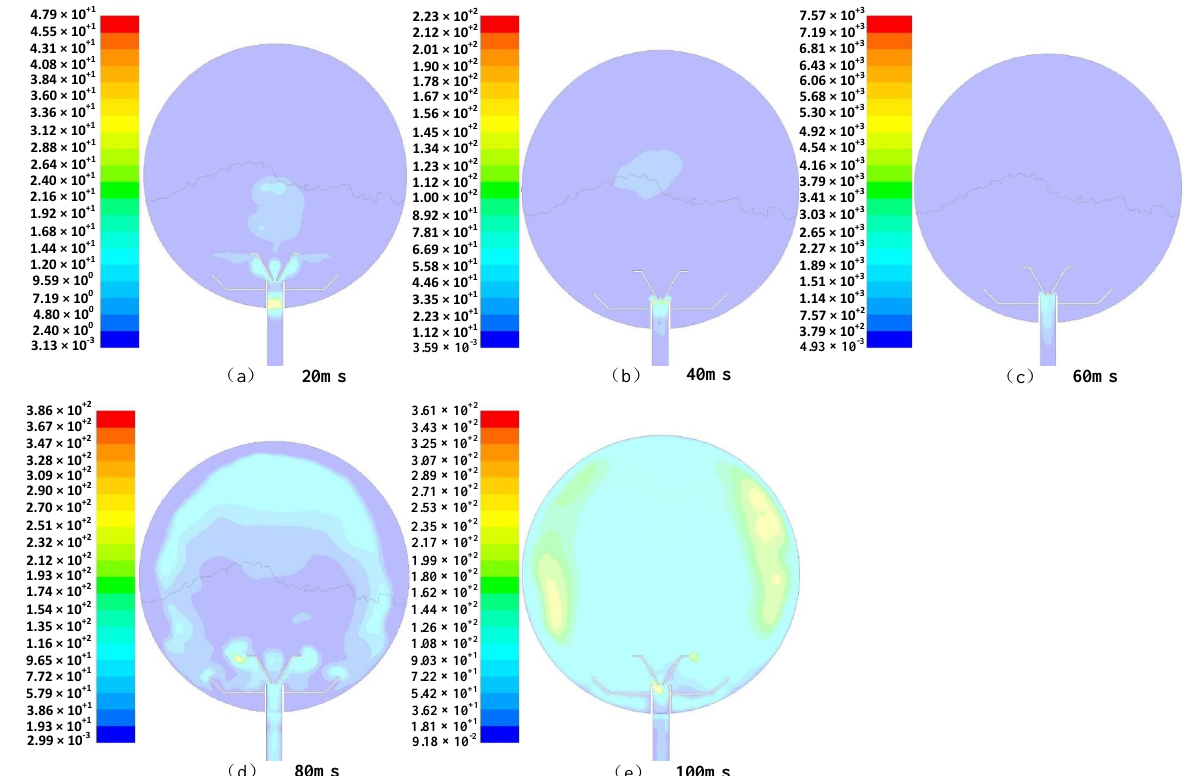
Figure 12. Evolution of turbulent kinetic energy (m 2 /s 2 ). As shown in Figure 13, at the initial moment of dust dispersion, the velocity of the flow field gradually increased and then decreased. When the dust was ignited, the tem- perature increased sharply, and the velocity of the flow field increased sharply until reach- ing its maximum value. Burning dust consumes the kinetic energy of the dust as a result of gravity and mutual friction. Therefore, after the dust moves to the top of the container, it continues to repeat the process of rising–falling–rising movement until the work of grav- ity has consumed all of the kinetic energy of the dust. The flow field velocity decreased relatively slowly. As shown in Figure 14, the density decreased rapidly in the ignition area, and as combustion progressed, the low-density area gradually increased until it possessed a cir- cular shape, and finally, at the end of the deflagration, the density gradually became lean and uniform.